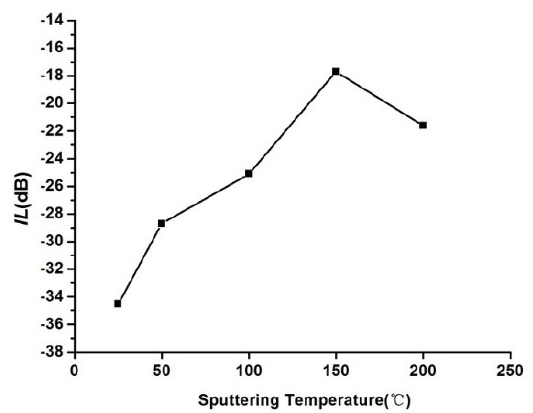
Figure 8. Relationship between the sputtering temperature and the insertion loss.